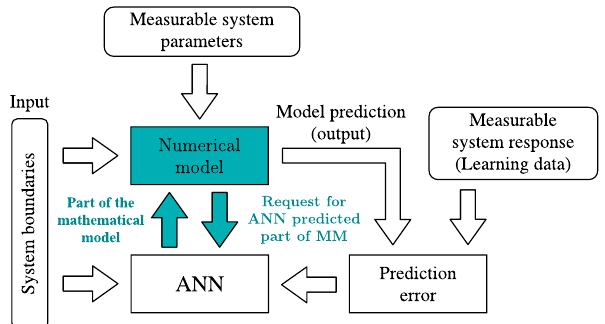
Figure 2. The Interactive Mathematical Modeling-Artificial Neural Network block